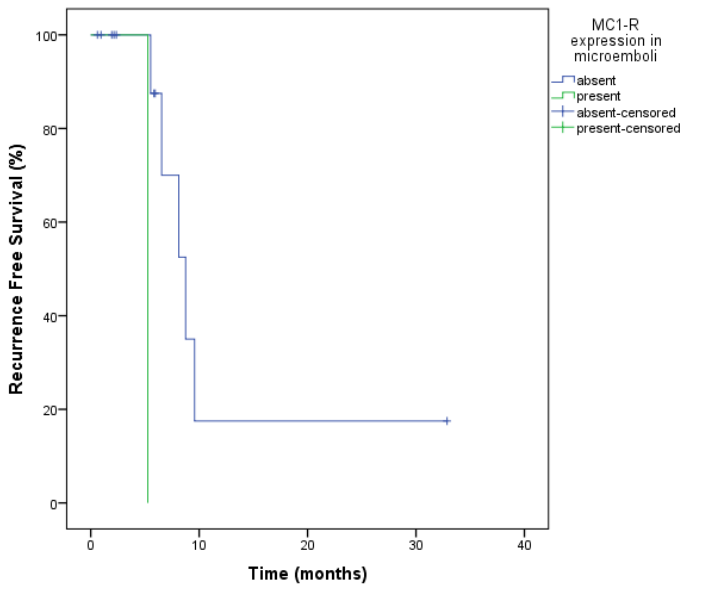
Figure 4. Recurrence-Free Survival analysis of ovarian cancer patients for MC1-R expression in CTM. The presence of a microemboli with MC1-R expression at the second follow-up was also determinant for worse RFS (5.26 vs. 13.1 months; p = 0.008).